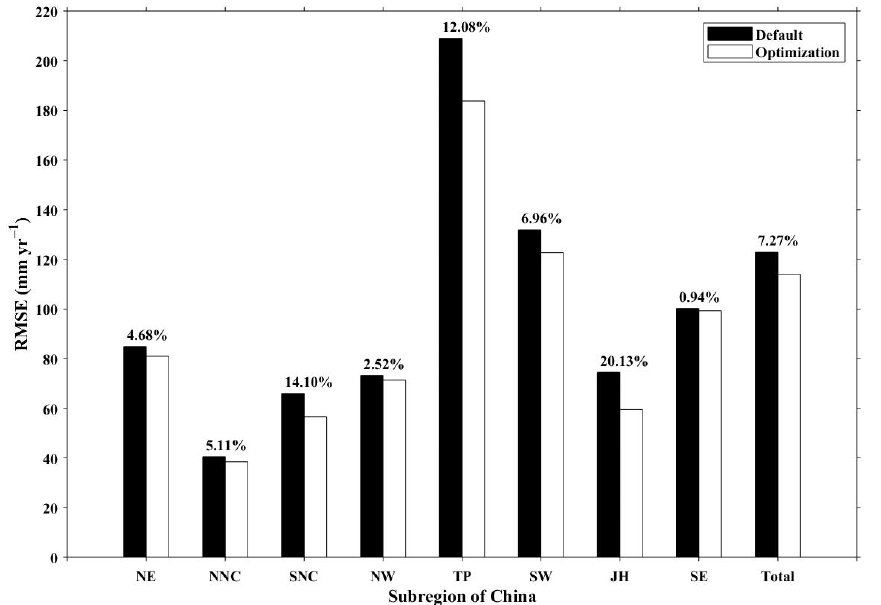
Figure 7. Comparisons of evapotranspiration simulations using default parameters and optimal parameters in the eight subregions of China.